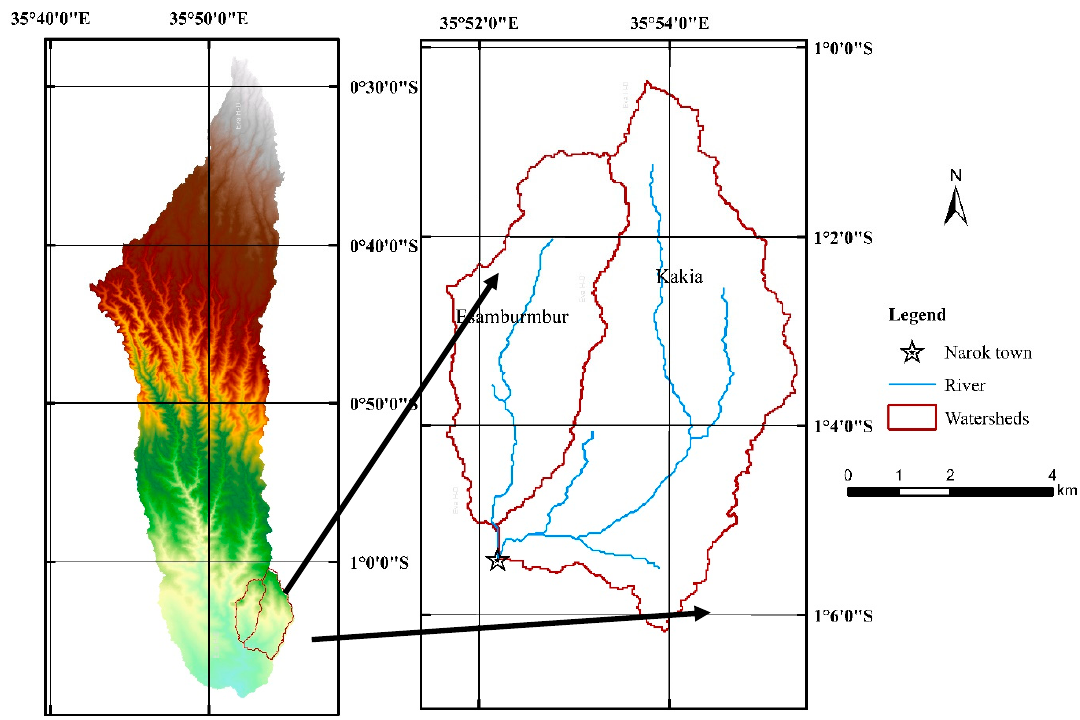
Figure 1. Kakia and Esamburmbur sub-catchments.